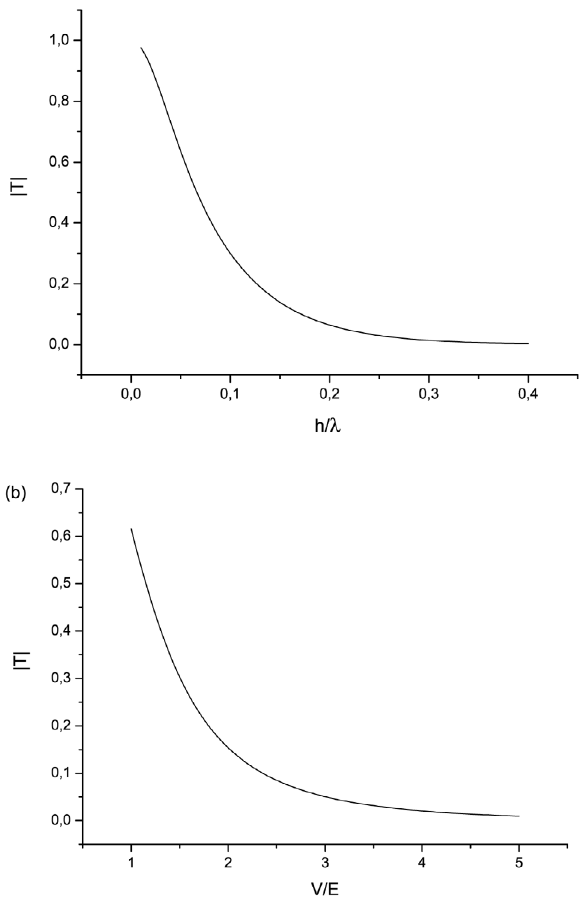
Figure 4. Absolute value of the transmission coefficient of an elec- tron through a potential as a function of the width h and height V (properly normalized). In (a) V = 10 E and in (b) h = 0.5 nm.